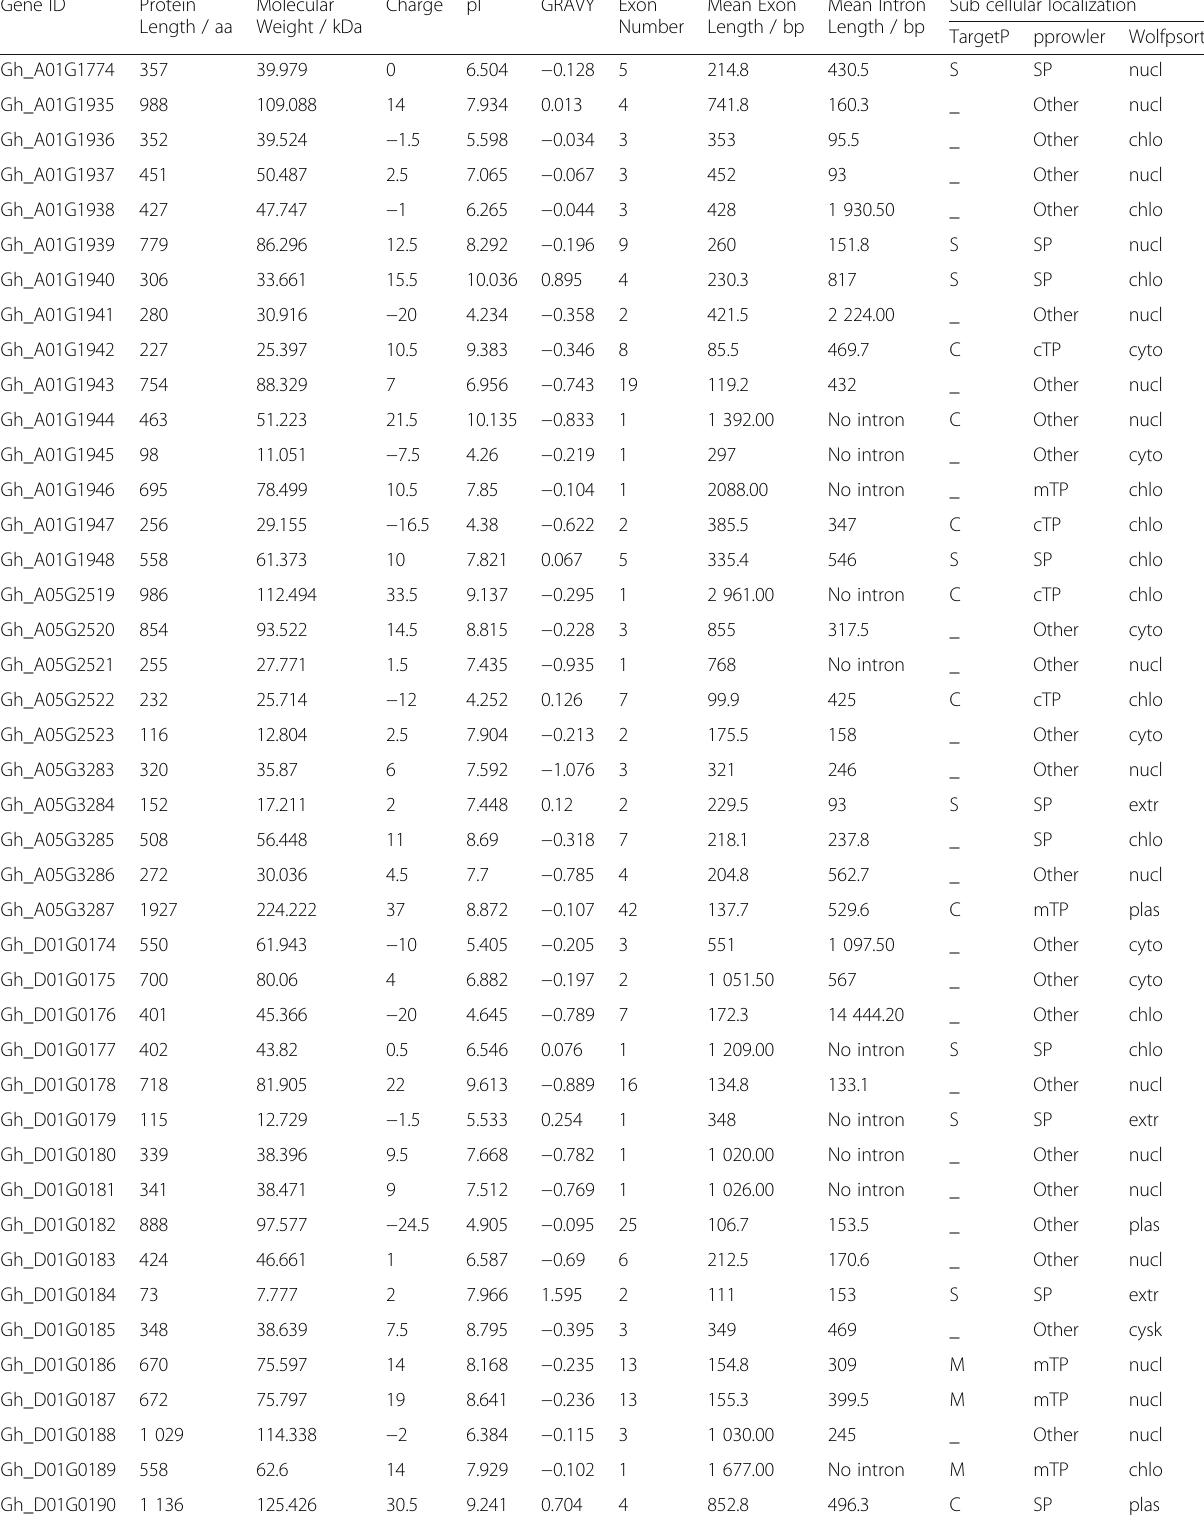
Table 4 Physiochemical properties and sub cellular localization prediction of the mined genes within the major clusters of the consistent